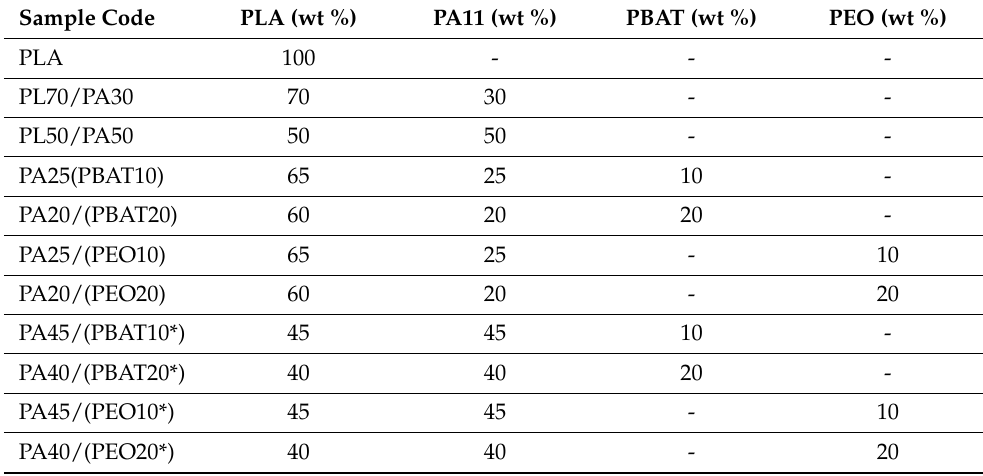
Table 4. Coding and formulation of the samples